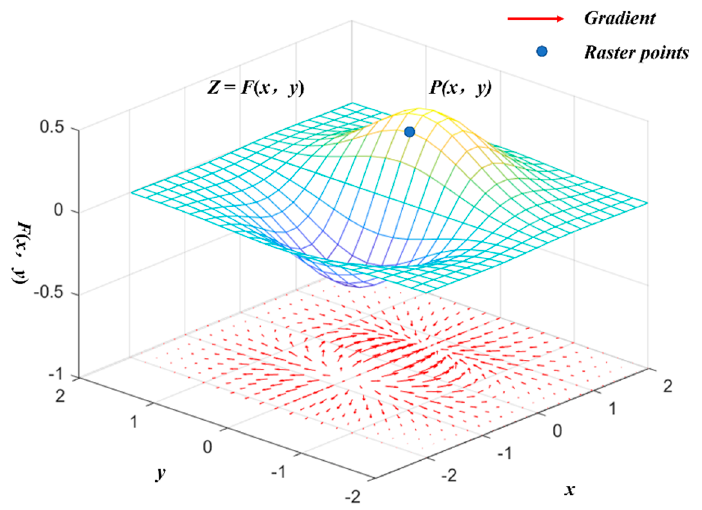
Figure 7. Gradient calculation.